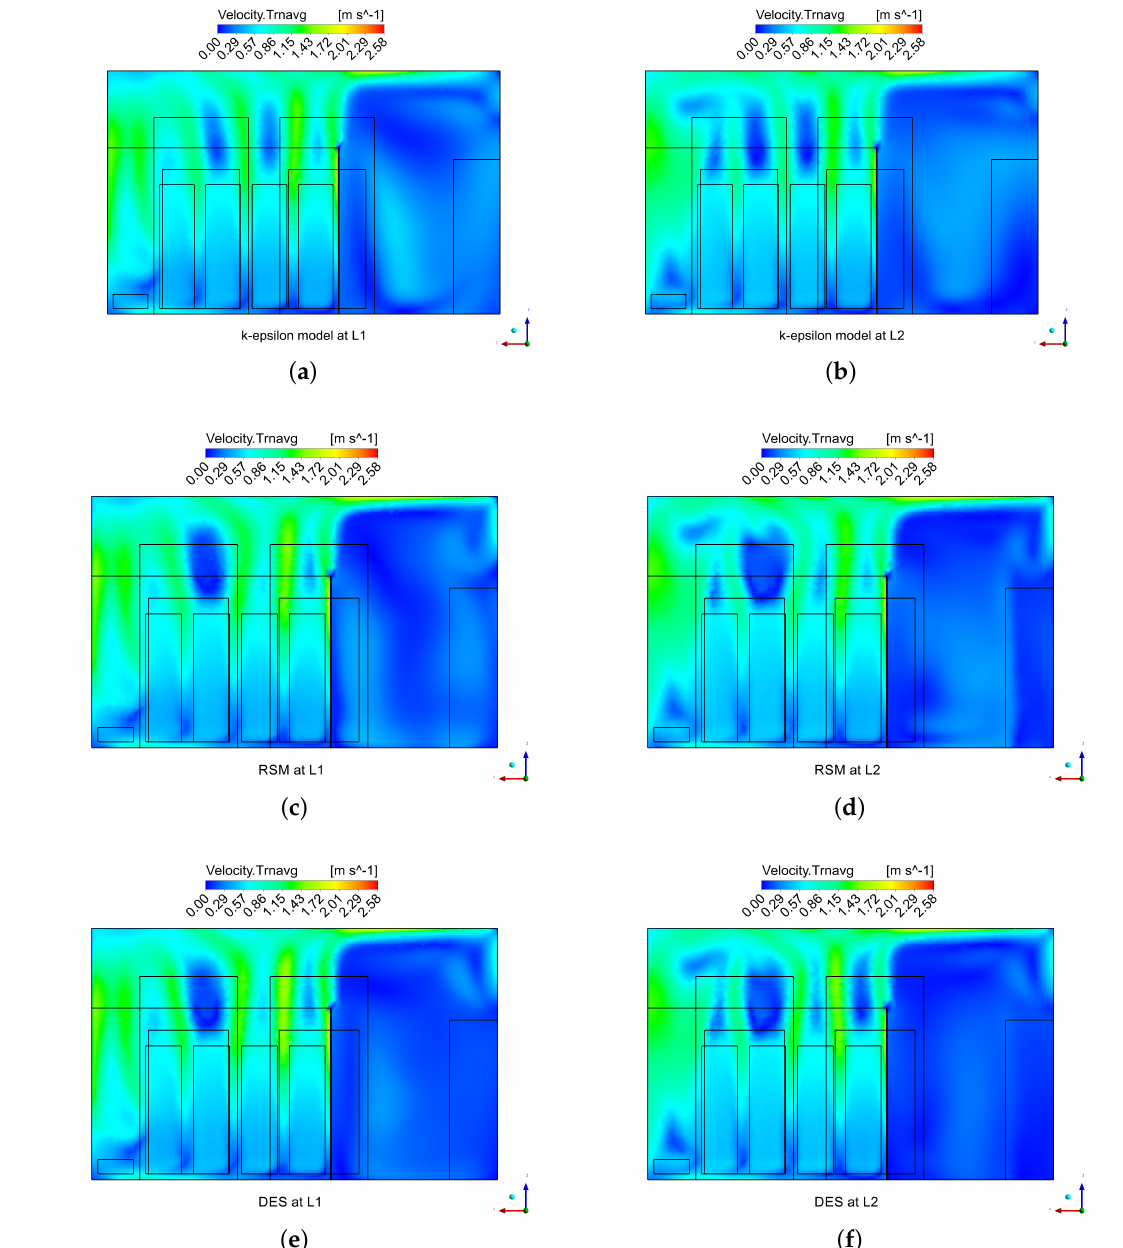
Figure 9. Velocity on planes at ( a ) L1 and ( b ) L2 for the k – ε model, ( c ) L1 and ( d ) L2 for RSM and ( e ) L1 and ( f ) L2 for